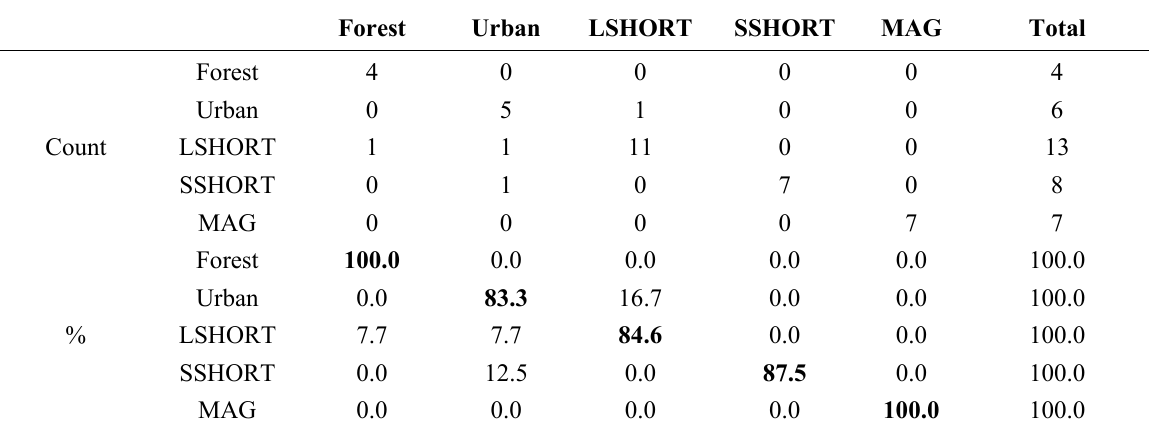
Table 3c. Classification results and predicted group membership.